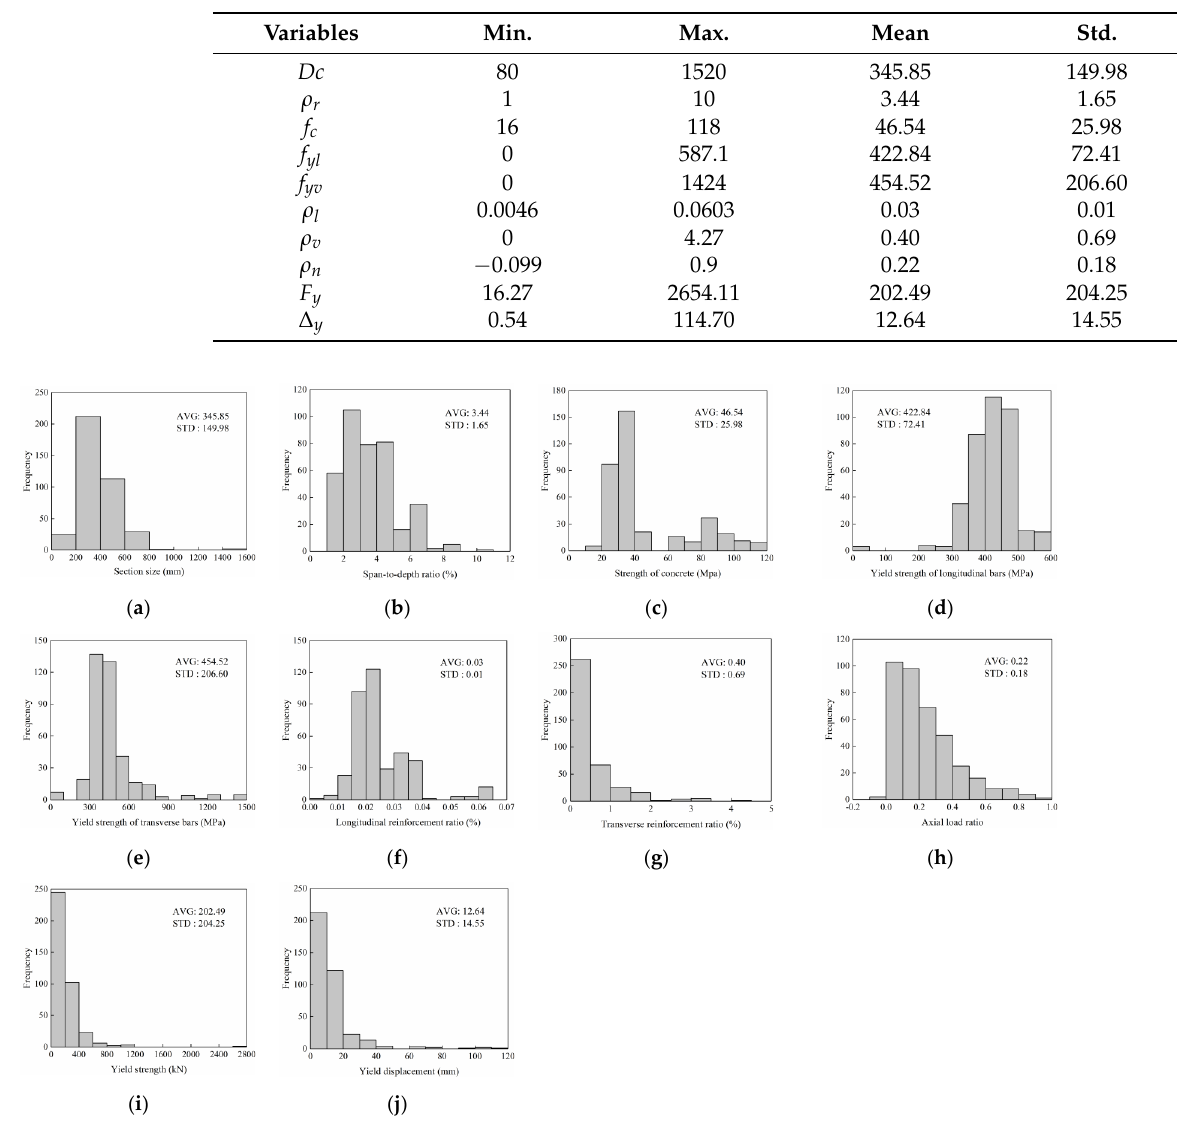
Table 3. Statistical description of the input and output variables. Table 2. Statistical description of the input and output variables.